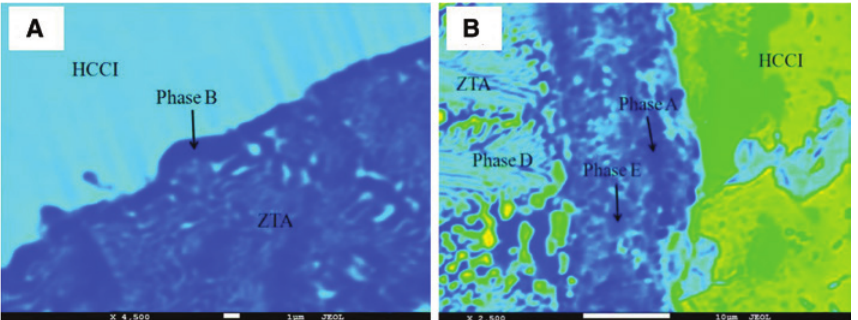
Figure 8: Interfacial transition layer by EPMA.